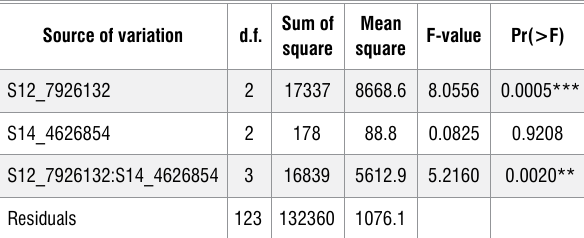
Table 4: Analysis of variance based marker output for mean incidence of cassava mosaic disease Source of variation